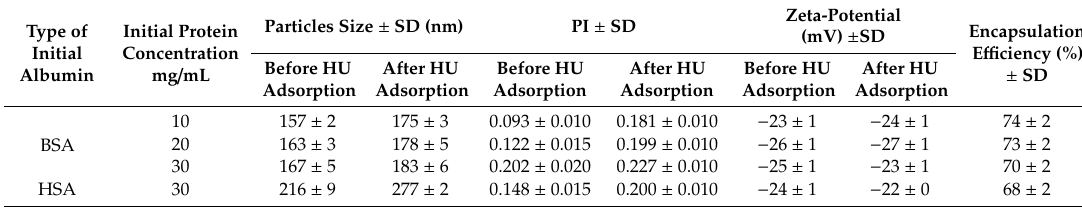
Table 1. Characteristics of HSA and BSA nanoparticles containing absorbed HU.